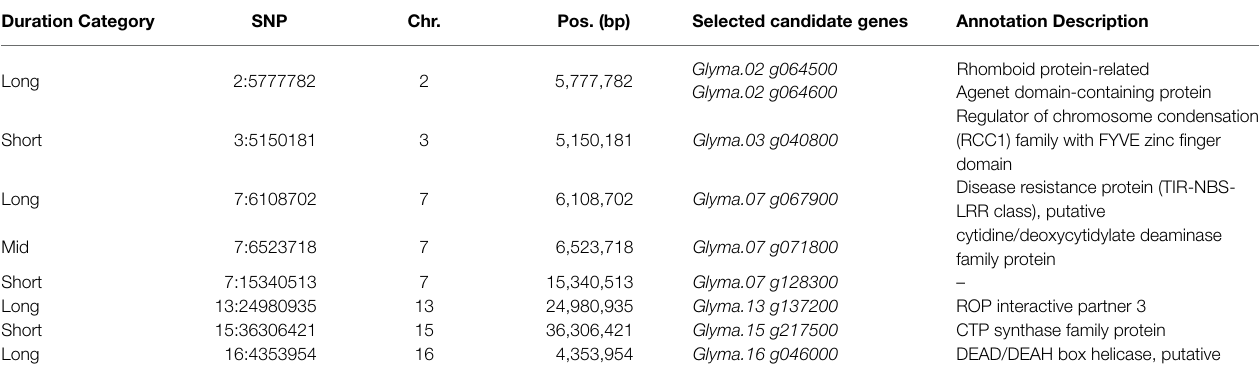
TABLE 1 | Selected single-nucleotide polymorphisms (SNPs) associated with above-ground biomass mapped inside potential candidate genes in the soybean genome. Duration Category SNP